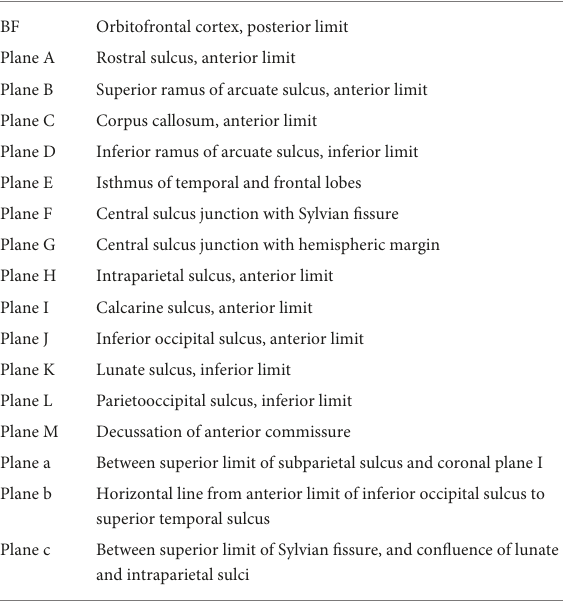
TABLE 6 Parcellation units—macaque HOA (mHOA). TABLE 7 Macaque HOA (mHOA) anatomical